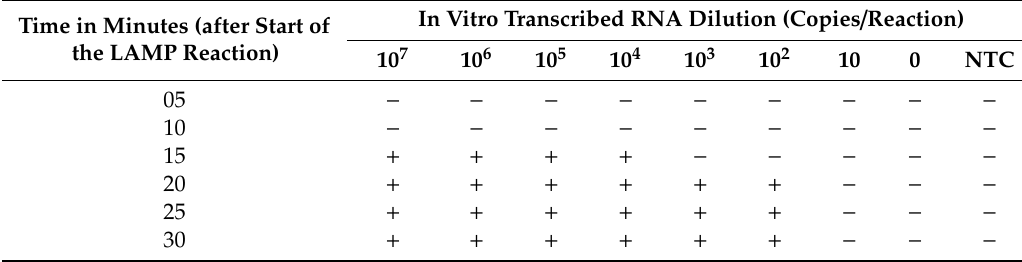
Table 1. Reaction times to visually detect LAMP